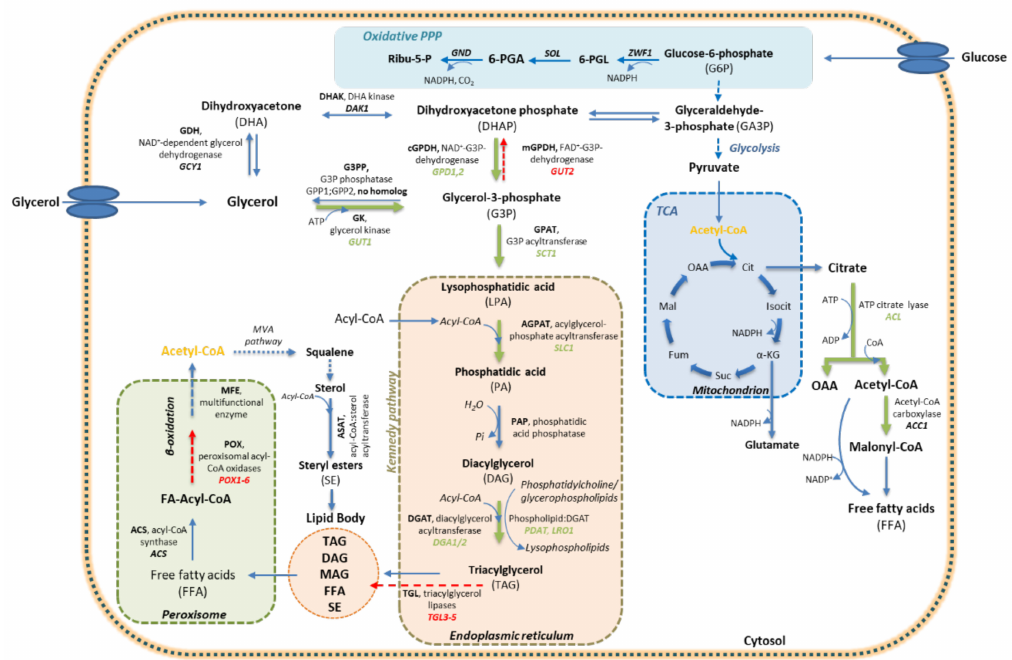
Figure 1. Metabolic pathways and cellular compartments involved in glycerol and glucose metabolism, triacylglycerol (TAG) biosynthesis and degradation. Yeasts catabolize glycerol us- ing two pathways. In the phosphorylative glycerol catabolic pathway, glycerol is phosphorylated to glycerol-3-phosphate (G3P) by a glycerol kinase (GK; GUT1 gene) and then converted to dihydroxy- acetone phosphate (DHAP) by a FAD + /FADH 2 -dependent mitochondrial bound G3P dehydrogenase (mGDPH; GUT2 gene). The second pathway includes oxidation of glycerol to dihydroxyacetone (DHA) by an NAD + -dependent glycerol dehydrogenase (GDH; GCY1 gene) and, after this, phos- phorylation to DHAP by a dihydroxyacetone kinase (DHAK; DAK1 gene). The red arrows indicate deleted reactions while the green arrows indicate gene overexpression as discussed in this study. Abbreviations of metabolites are 6-PGL, 6-phosphogluconolactone; 6-PGA, 6-phosphogluconate; Ribu-5-P, ribulose-5-phosphate; Cit, citrate; Isocit, isocitrate; a -KG, a -ketoglutarate; Suc, succinate; Fum, fumarate; Mal, malate; OAA, oxaloacetate; MAG, monoacylglycerol. Abbreviations of metabolic pathways are TCA, tricarboxylic acid cycle; MVA,